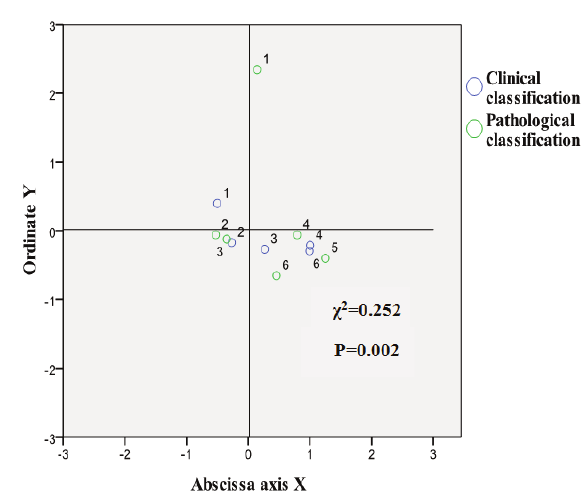
Figure 1: Corresponding analysis of clinical type and pathological type. According to pathological type (I = 1, II = 2, IIIa = 3, IIIb = 4, IV = 5, VI = 6) and clinical classification (I = 1, II = 2, III = 3, IV = 4, V = 5, VI = 6). After the data is assigned, the corresponding analysis is used, χ2 = 0.252, p = 0.002.